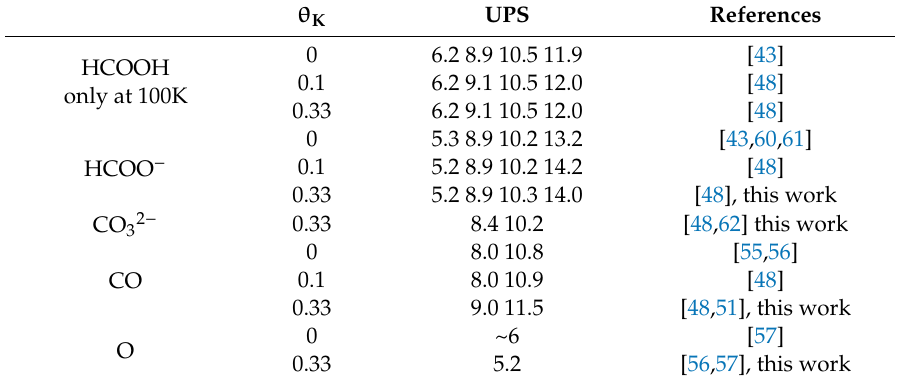
Table 1. Binding energies (in eV) of adsorbates observed following HCOOH on Rh(111) and K / Rh(111). θ K